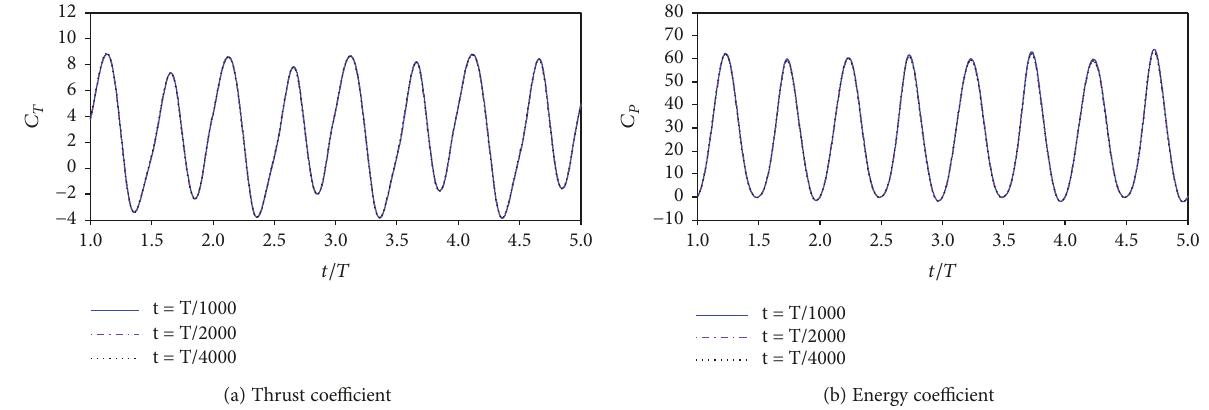
Figure 4: The time variation of thrust and energy coe ffi cients with three di ff erent iteration time